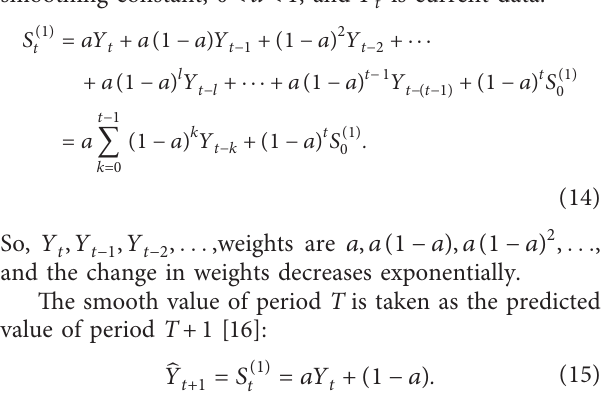
Figure 4: Impact of temperature on vulnerability.